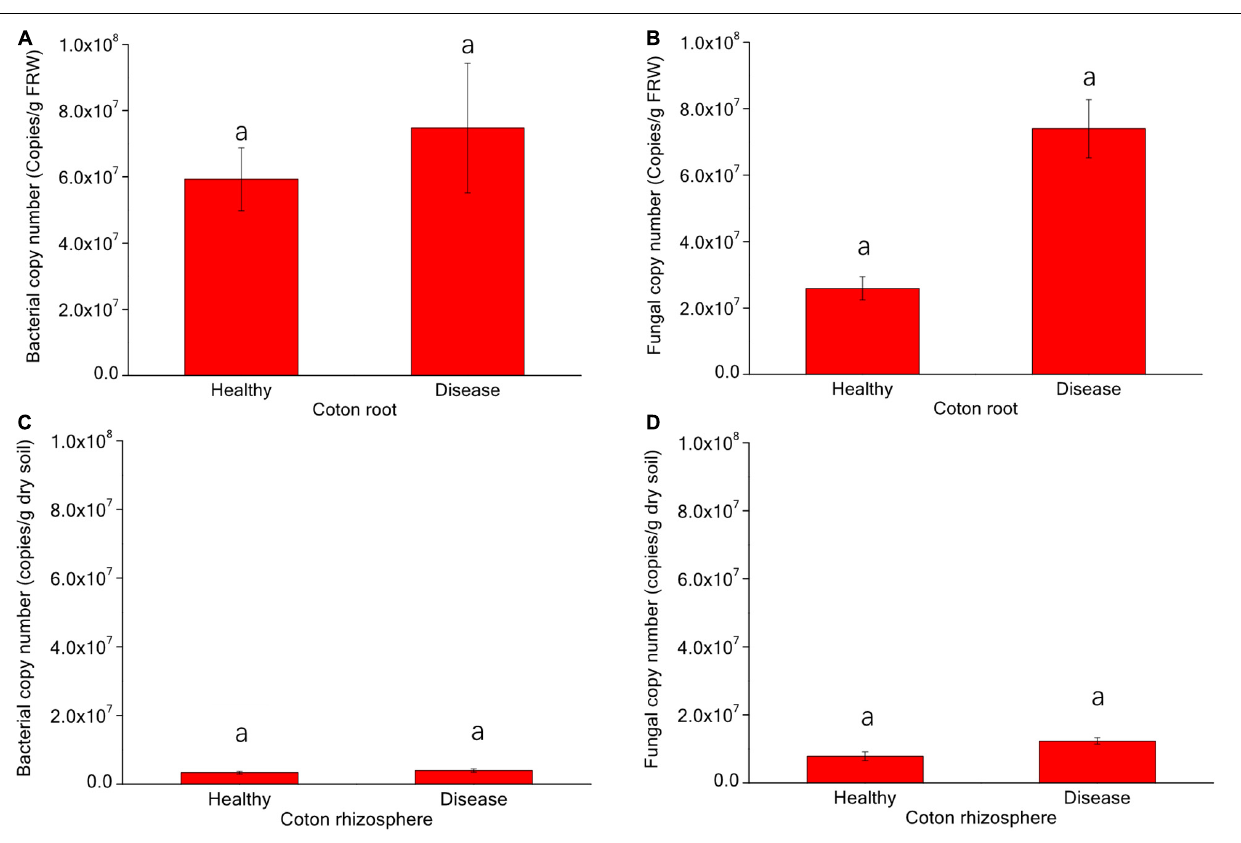
FIGURE 2 | Variation of numbers ( A endophytic bacteria; B endophytic fungi; C rhizosphere bacteria; and D rhizosphere fungi) of rhizosphere and endophytic bacteria and fungi in healthy and diseased cotton ( P >